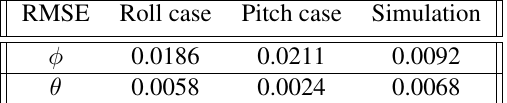
Table 2: RMSE values for the experimental roll and pitch experiments, and for a simulated dataset with D-